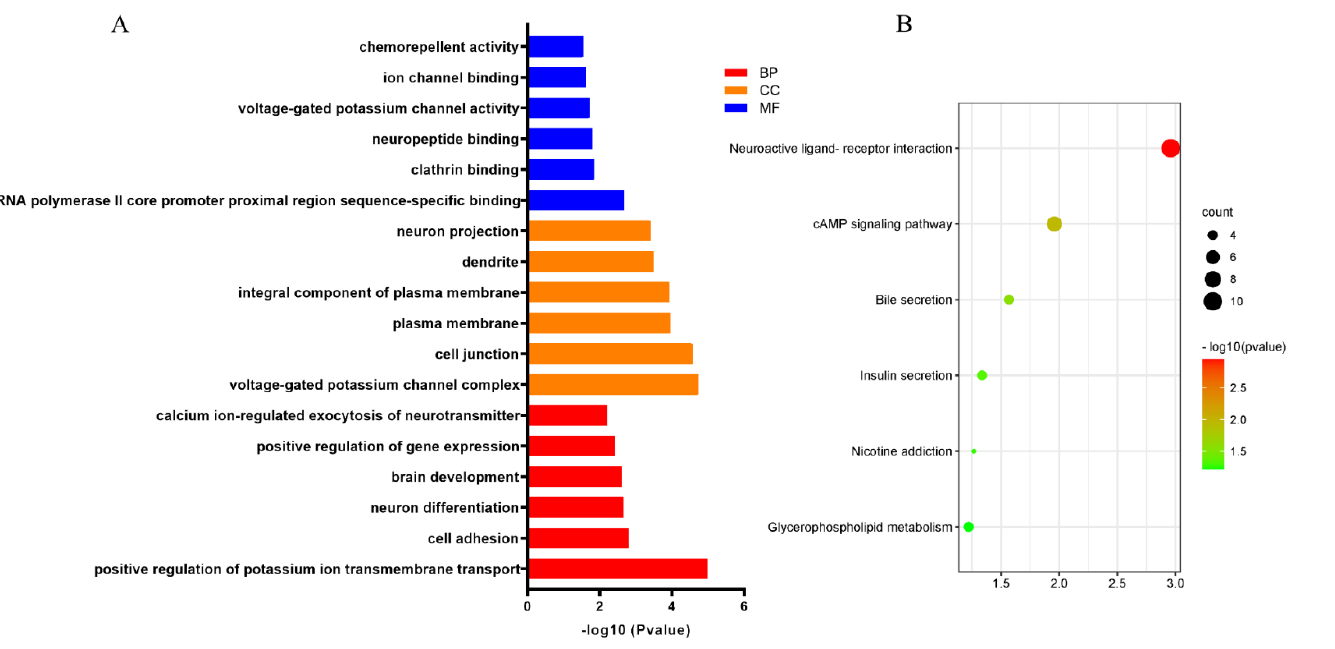
Figure 6. Functional enrichment analysis. ( A ) Top six significant GO enrichment annotations of the 185 overlapped genes, including BP, CC, MC. ( B ) Top six significant KEGG pathways. The degree of enrichment of displayed through color gradual changes of the node. The size of the dots represents gene counts in a pathway.